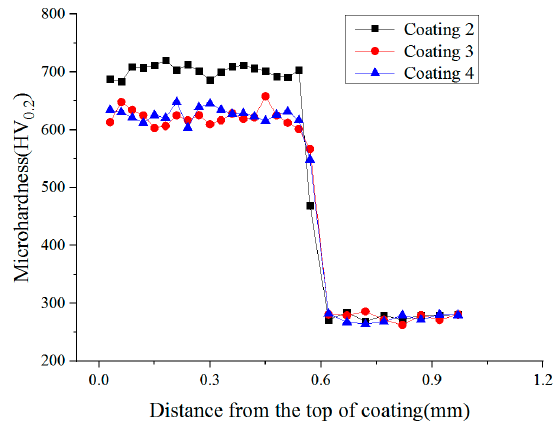
Figure 5. Microhardness distribution of coatings prepared with different heat treatments.